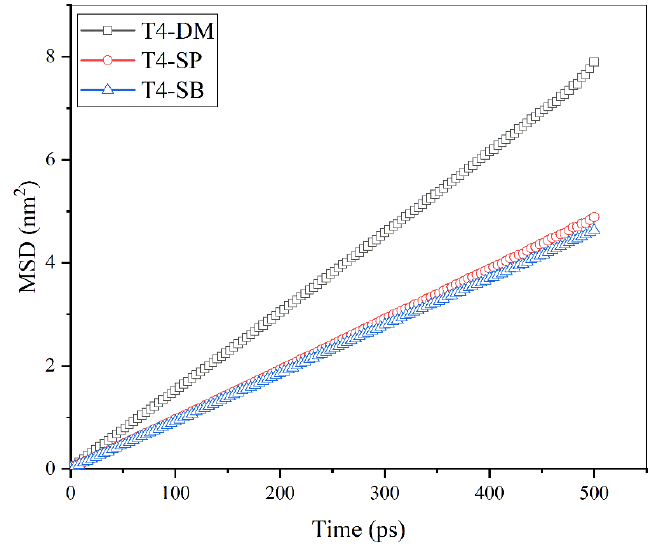
Figure 8. Mean square displacement of water molecules in the hydration layer of nonfouling membrane. Table 2. Dynamic properties of hydration layer water molecules above three antifouling membranes including average residence time and diffusion coefficient.